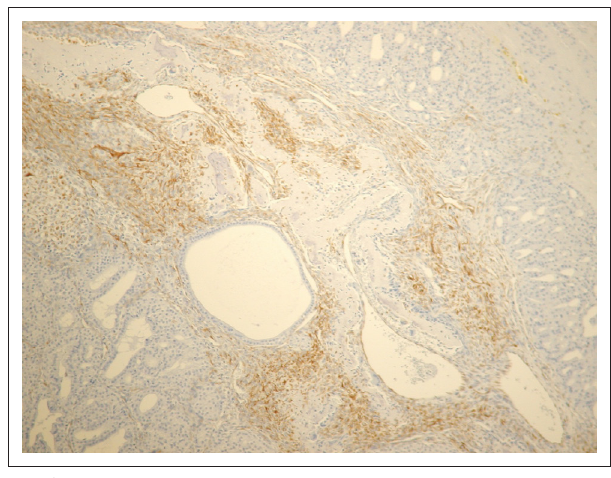
Magnification: 4×. FIGURE 2: Micrograph of the thyroid carcino-sarcoma stained with vimentin.